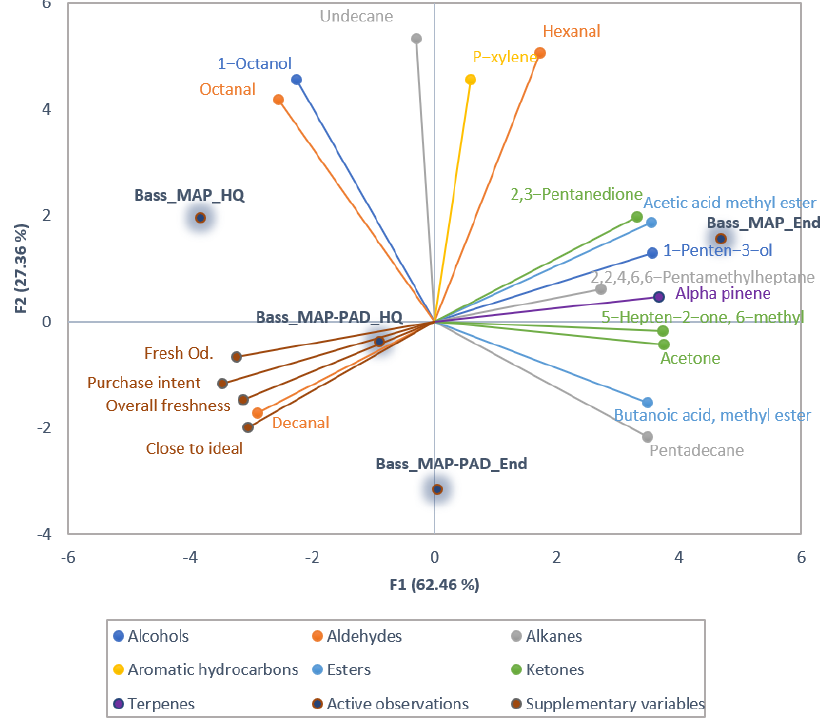
Figure 3. Principal component analysis (PCA) biplot of volatile compounds that differed significantly or showed a tendency for difference ( p < 0.1) among the seabass fillets, with consumer perceived freshness attributes presented as supplementary data.